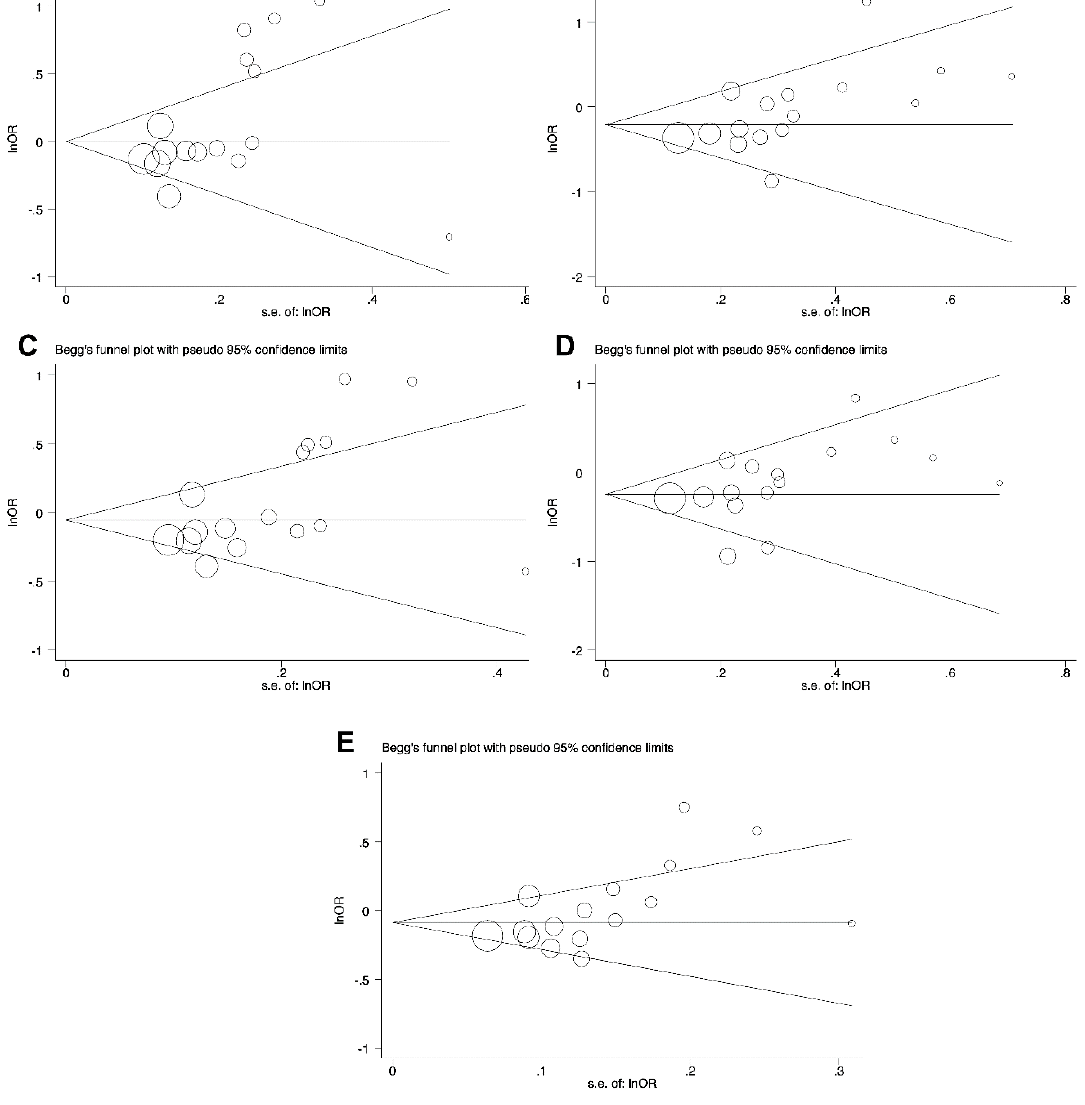
Figure 5. The funnel plot of PD-1 rs2227981 polymorphism for the test of publication bias for CT vs. CC ( A ), TT vs. CC ( B ), CT+TT vs. CC ( C ), TT vs. CT+TT ( D ), and T vs. C ( E ).